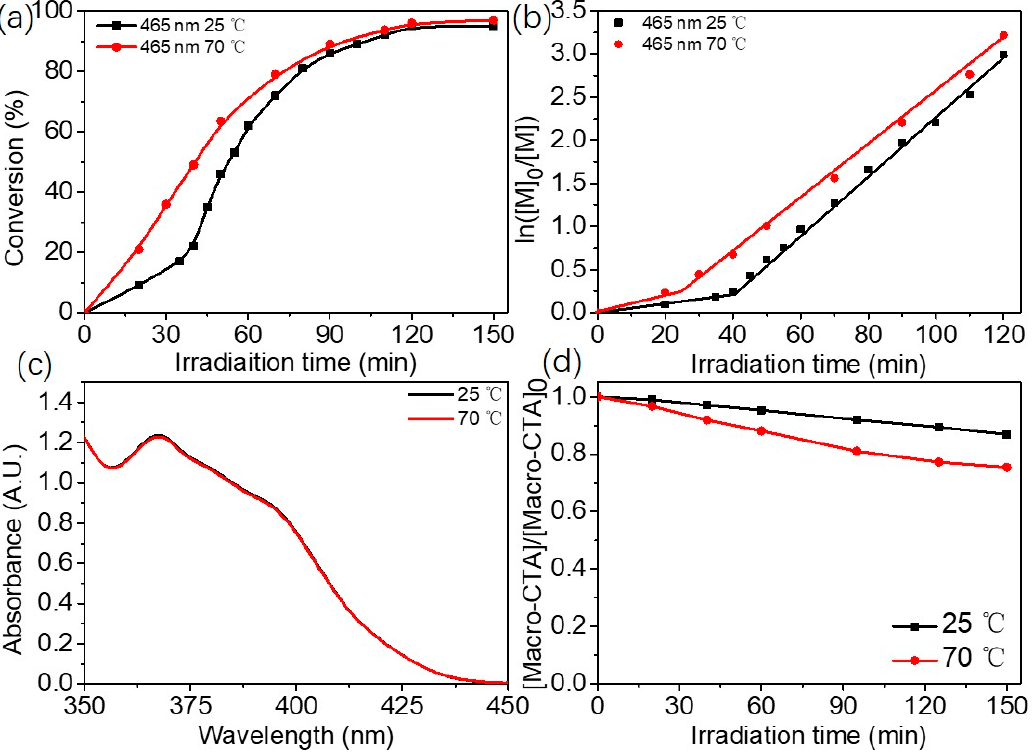
Figure 3. ( a ) Polymerization kinetics of blue light-initiated RAFT dispersion polymerization of